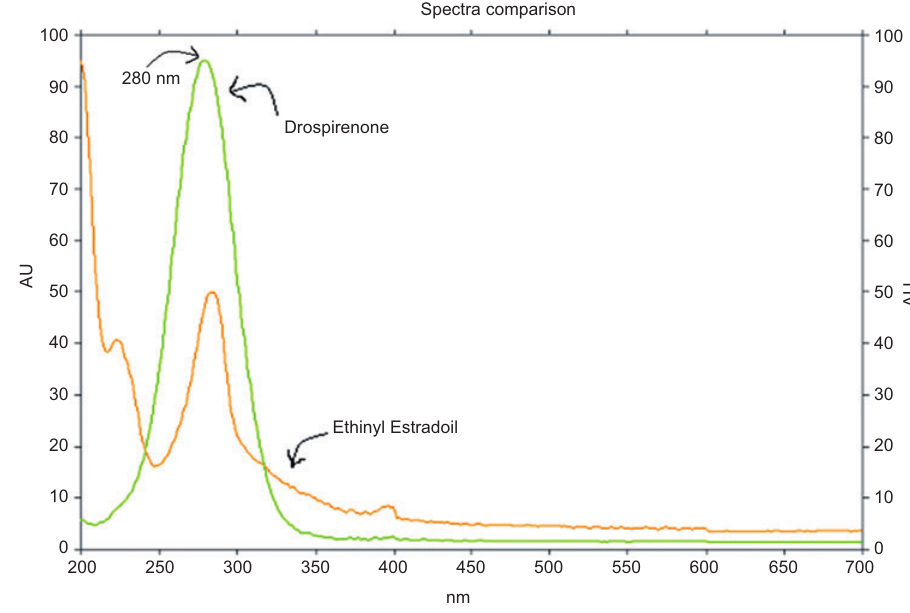
Figure 6 Overlay of UV spectra for ethinyl estradiol and